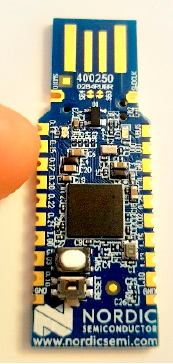
Figure 10. nRF52840 dongle used to configure the WirelessHART network during the research [78].